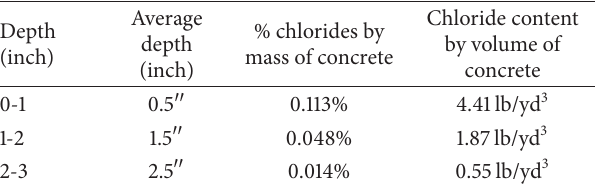
Figure 4: Experimental laboratory setup.